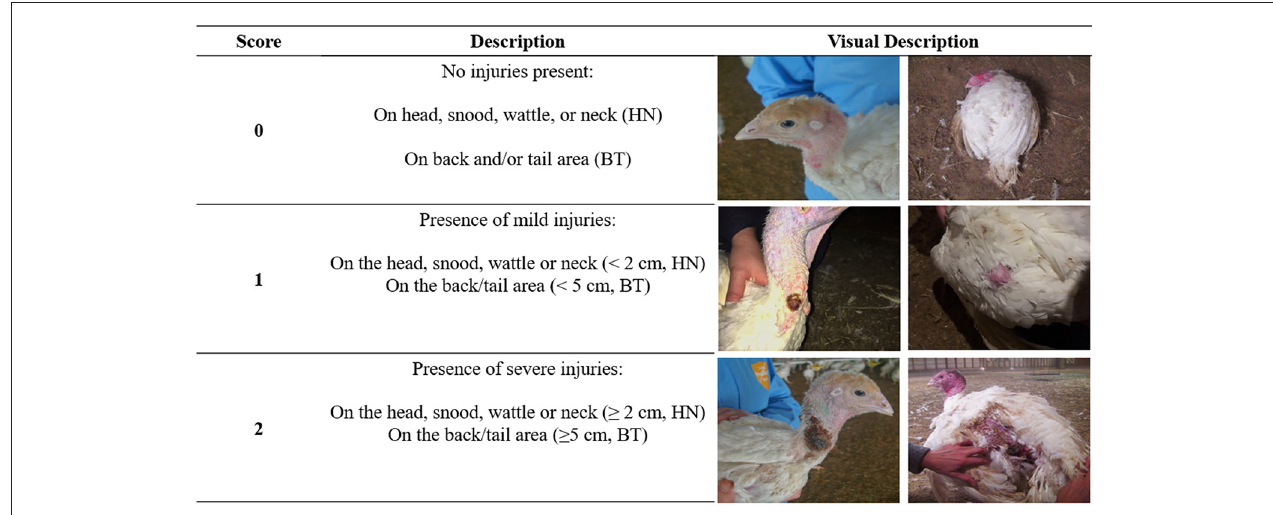
FIGURE 1 | Simplified scoring system for farmers to score head/neck (HN, left images) and back/tail (BT, right images) on a subset of turkeys in their flock.